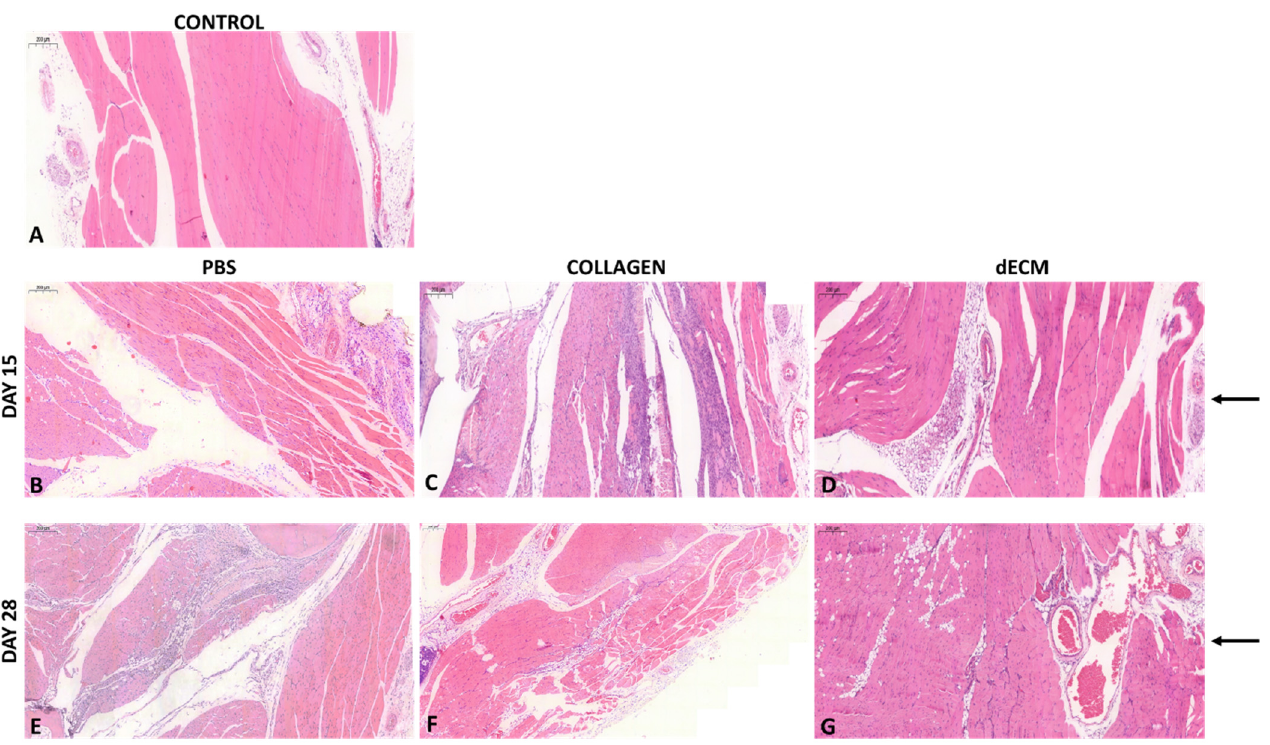
Figure 6. Histological samples of BALB/c mice. ( A ) native structure of a male BALB/c mouse, (control). ( B – D ) hind limbs isolated from mice treated with PBS, collagen and 8 mg/mL dECM at day 15. ( E – G ) hind limbs isolated from mice treated with PBS, collagen and 8 mg/mL dECM at day 28. The arrows highlight the injection site and the presence of vessels. 5 × magnification. Scale bar 200 μ m.